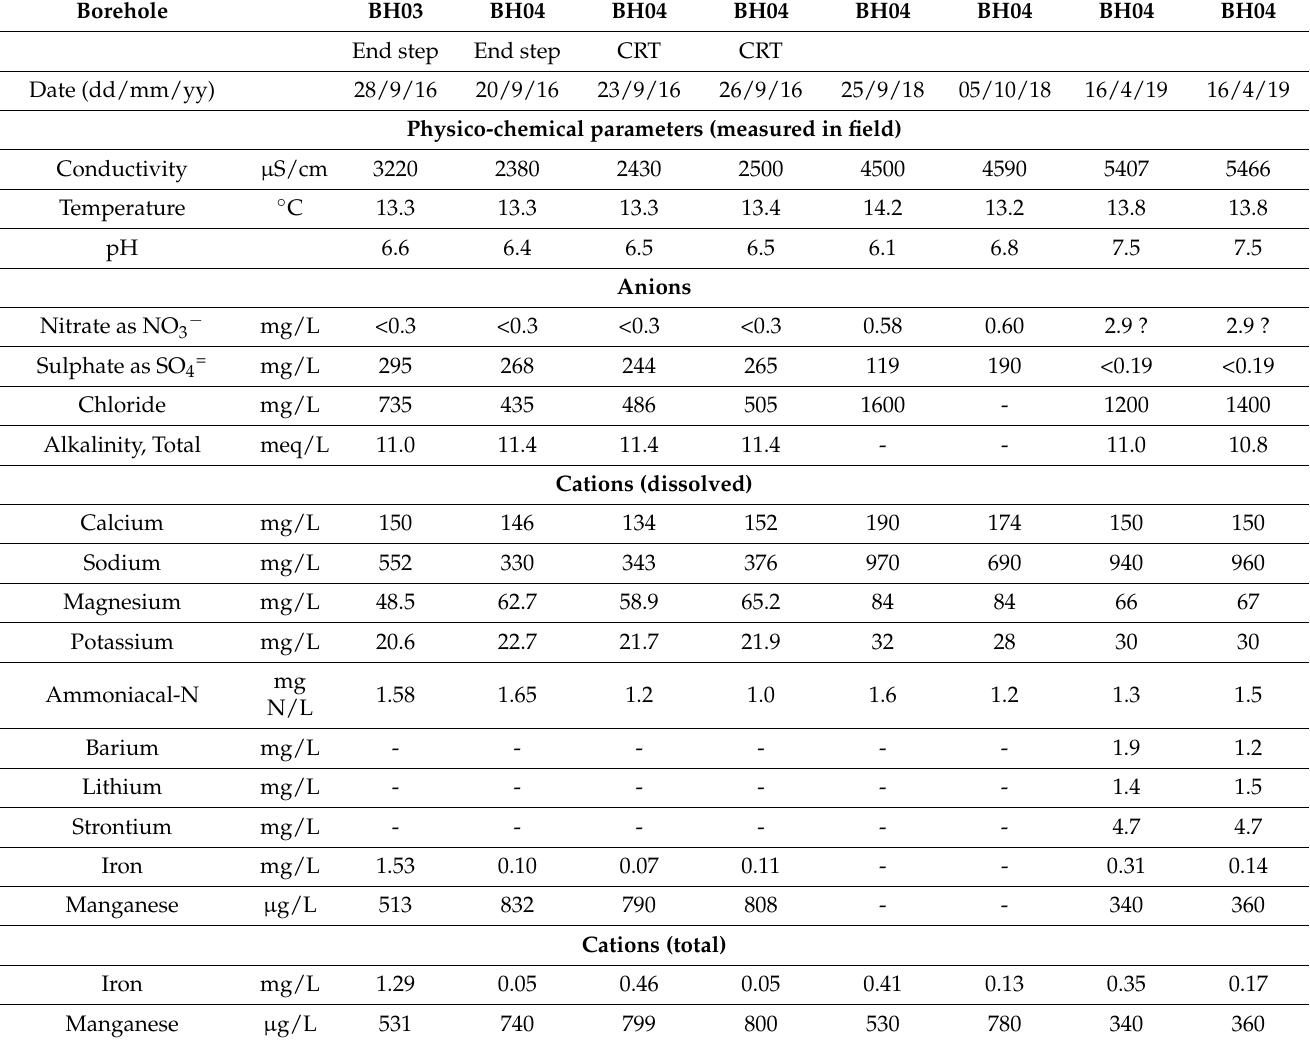
Table 4. Selected water chemistry data from pumping of (first column) Nest Road BH03 prior